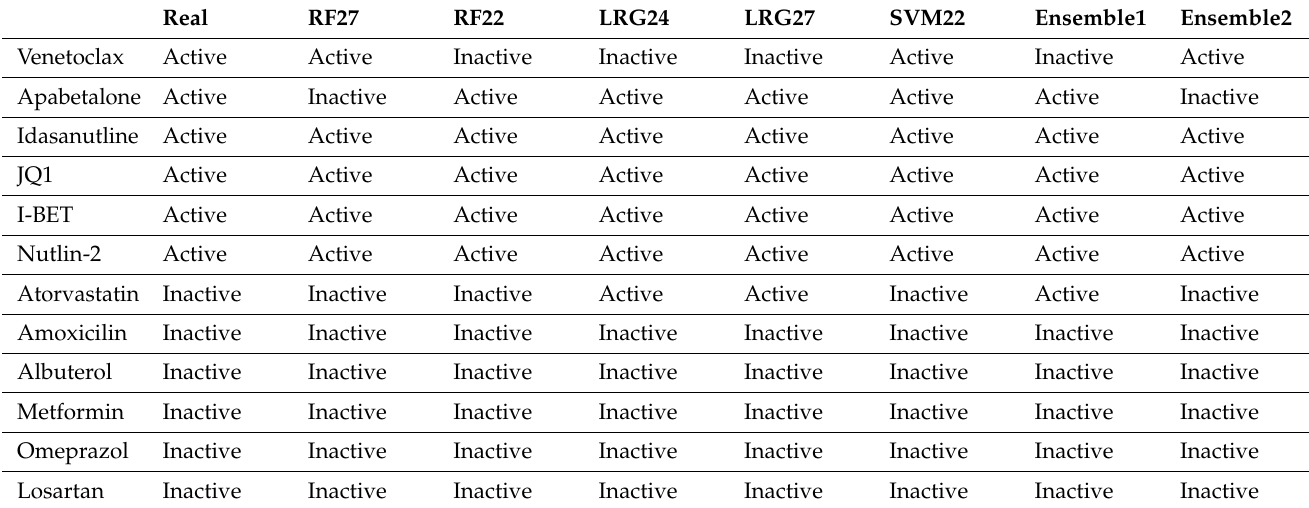
Table 3. Models’ prediction for individual